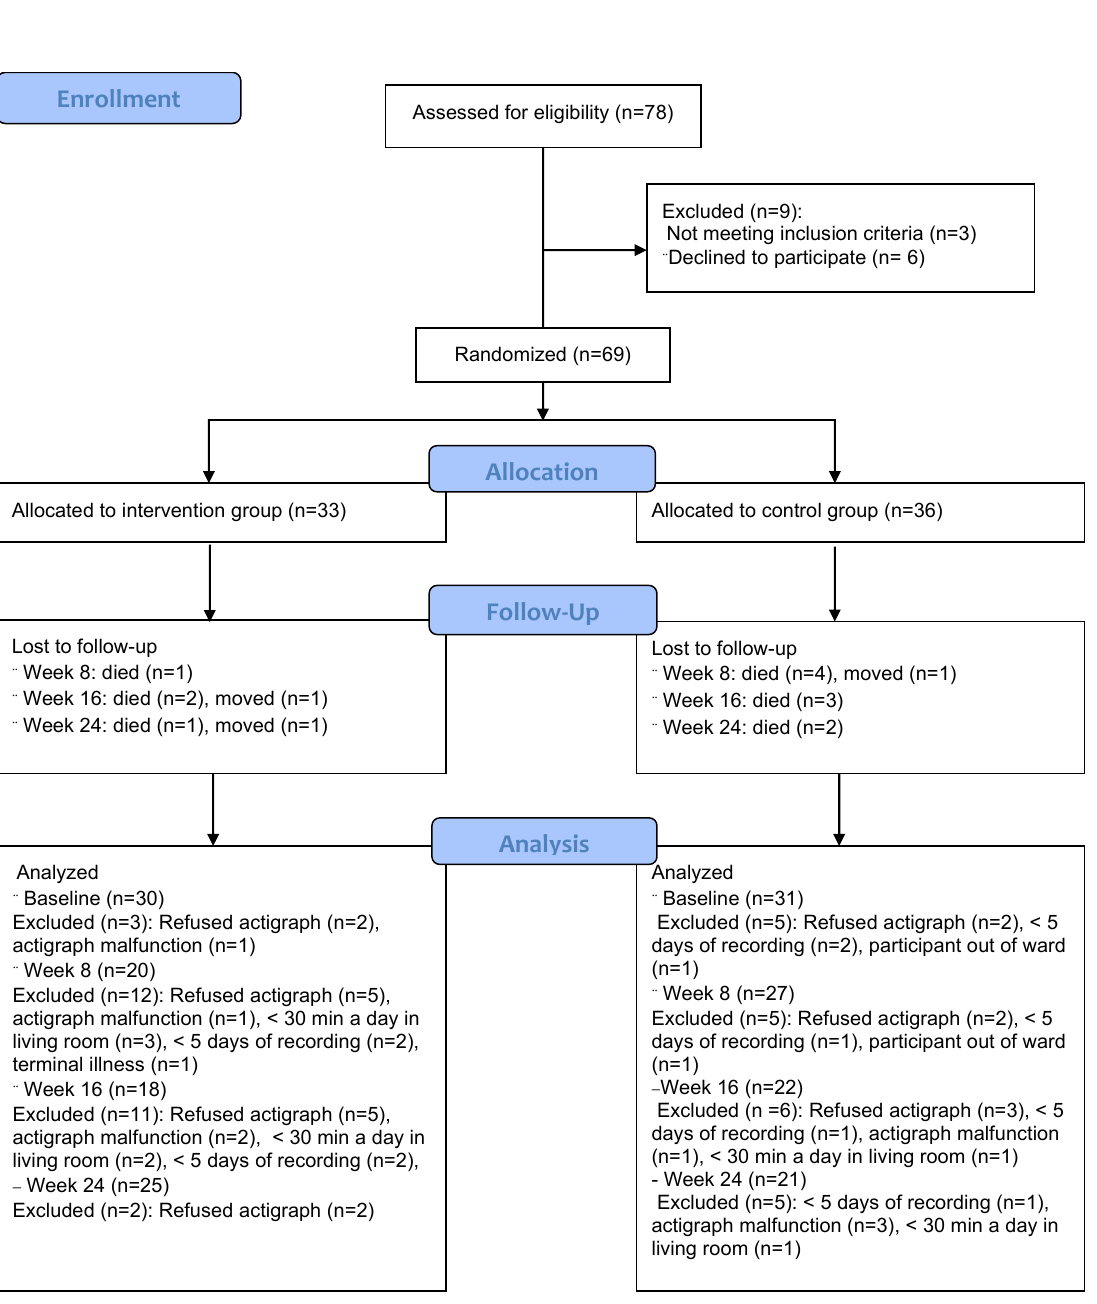
Figure 2. Flow diagram showing participant inclusion, allocation, and attrition through each stage of the trial until analy- sis.